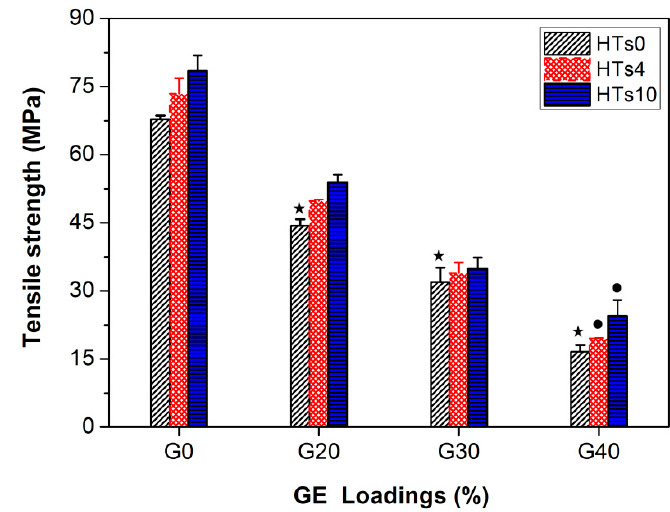
Figure 6. Tensile strength (TS) of FG/GE/HT composites with various HT and GE loadings. * denotes significant difference between FG films containing different percentages of GE ( p < 0.05). ● denotes significant difference in FG/GE40 films containing different percentages of HT compared with FG/GE40 only film ( p < 0.05).